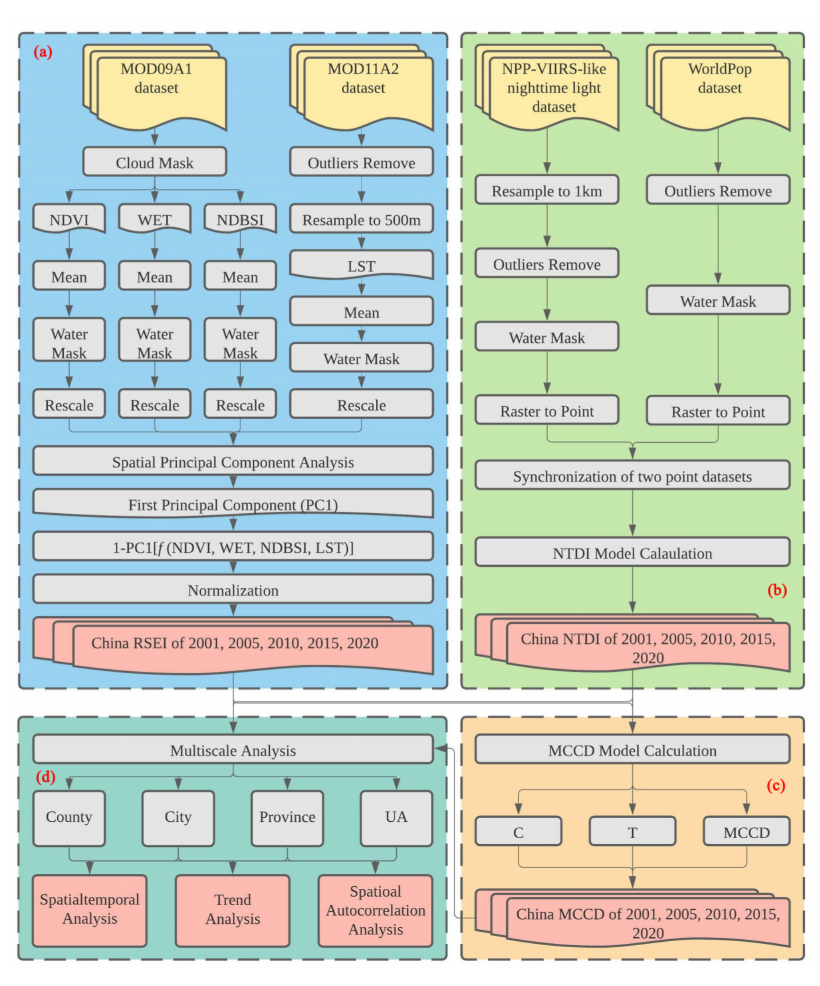
Figure 2. Framework of this